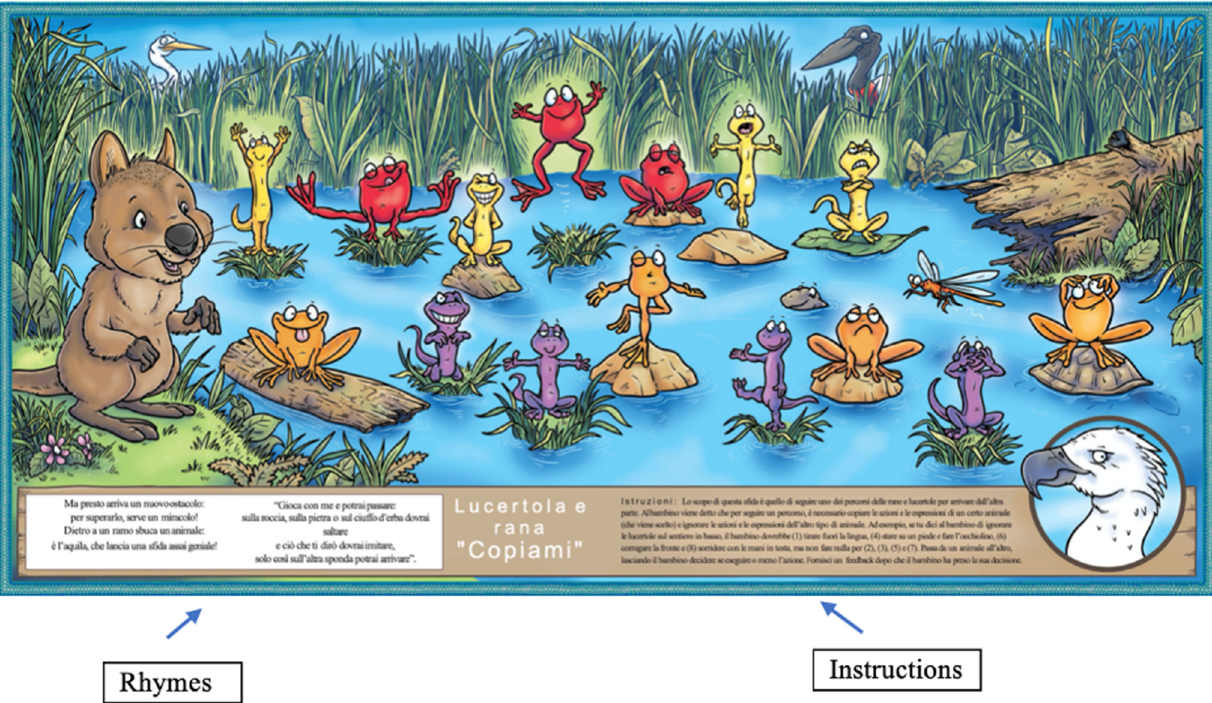
Figure 2. A representation of the QQQ IT activity “Serena Sea Eagle’s. Copy Me!” (modified from Steven Howard & Simon Chadwick [24]).